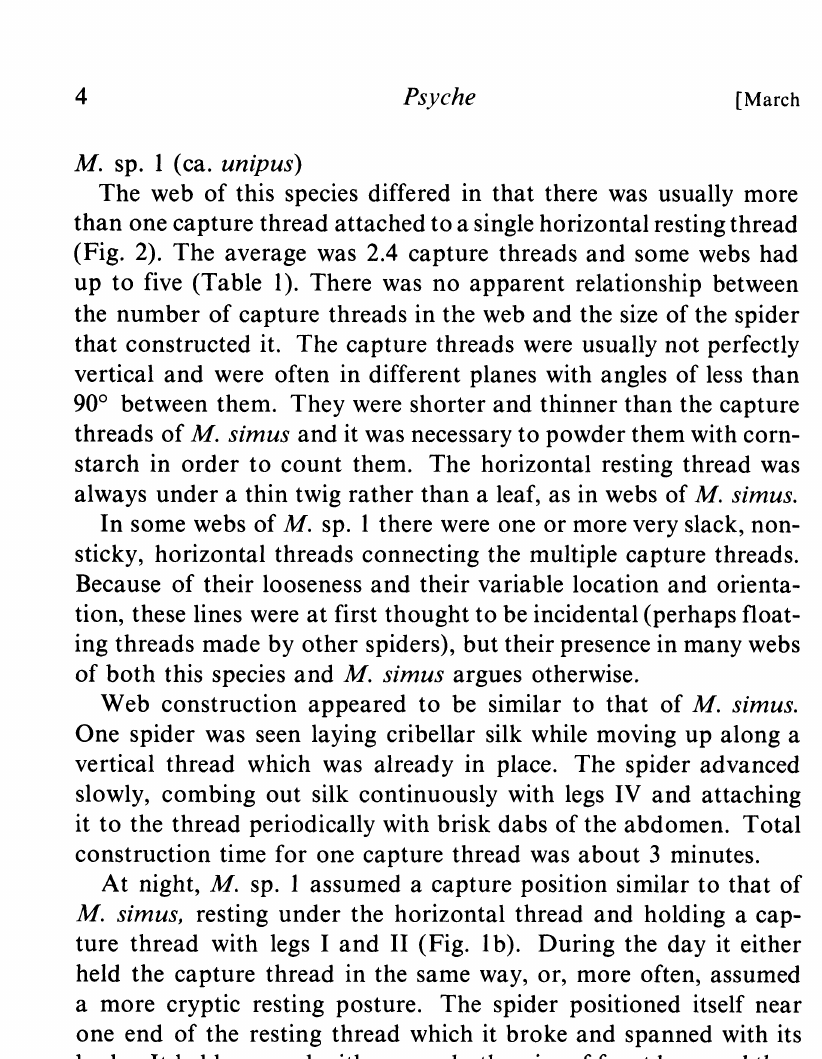
Table 1. Numbers of sticky capture threads in 66 webs of Miagrammopes sp. (ca. unipus) and 22 webs of M. sp.